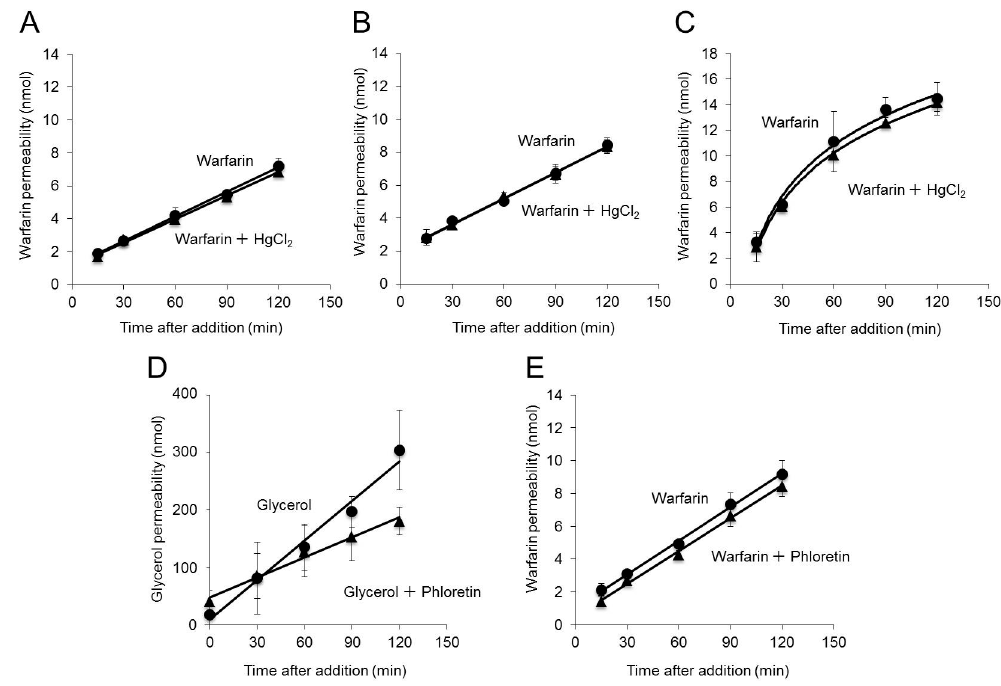
Figure 2. Effect of inhibition of AQP3 function on warfarin permeability. Caco-2 cells were plated in Transwell plates and incubated for 21 days. ( A ) Warfarin alone or a combination of warfarin and HgCl 2 was added to the apical side of the Transwell plate. ( B ) Warfarin alone or a combination of warfarin and HgCl 2 was added to the apical side of the Transwell plate, and mannitol was added to the basal side. ( C ) Warfarin alone or a combination of warfarin and HgCl 2 was added to the apical side, and the Transwell plate was shaken on a plate mixer. ( D ) Glycerol alone or a combination of glycerol and phloretin was added to the apical side of the Transwell plate. ( E ) Warfarin alone or a combination of warfarin and phloretin was added to the apical side of the Transwell plate. The concentration of warfarin or glycerol on the basal side was measured. The data are presented as the mean ± SD for six experiments. Table 2. Effect of inhibition of AQP3 function on the P app of warfarin.